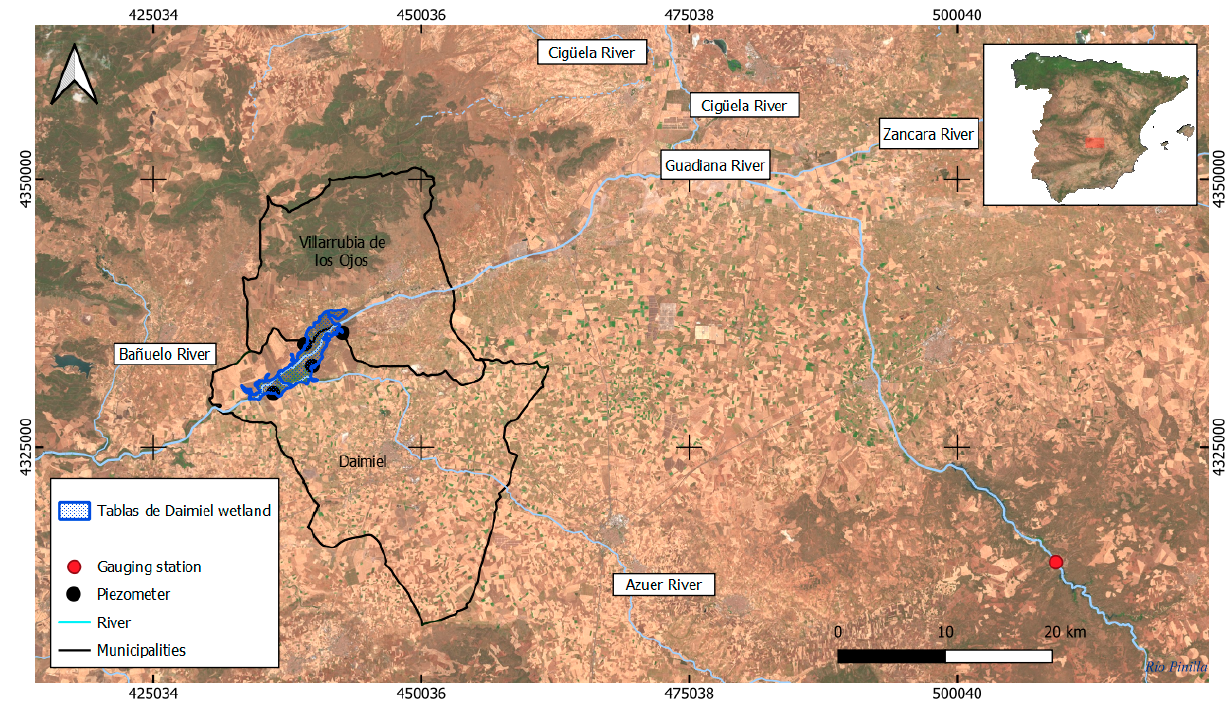
Figure 1. Study area including the perimeter of the Tablas de Daimiel National Park (blue polygon), gauging stations (red points), piezometers (black points), rivers (cyan lines), and municipalities in which the studied wetland is located (black